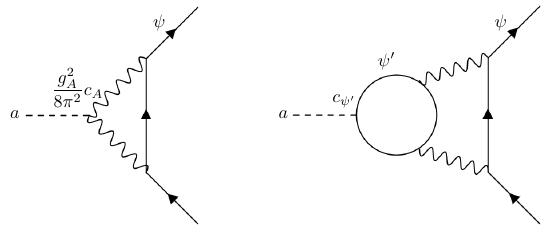
Figure 2 . Diagrams for the gauge-induced renormalization group running of c ψ